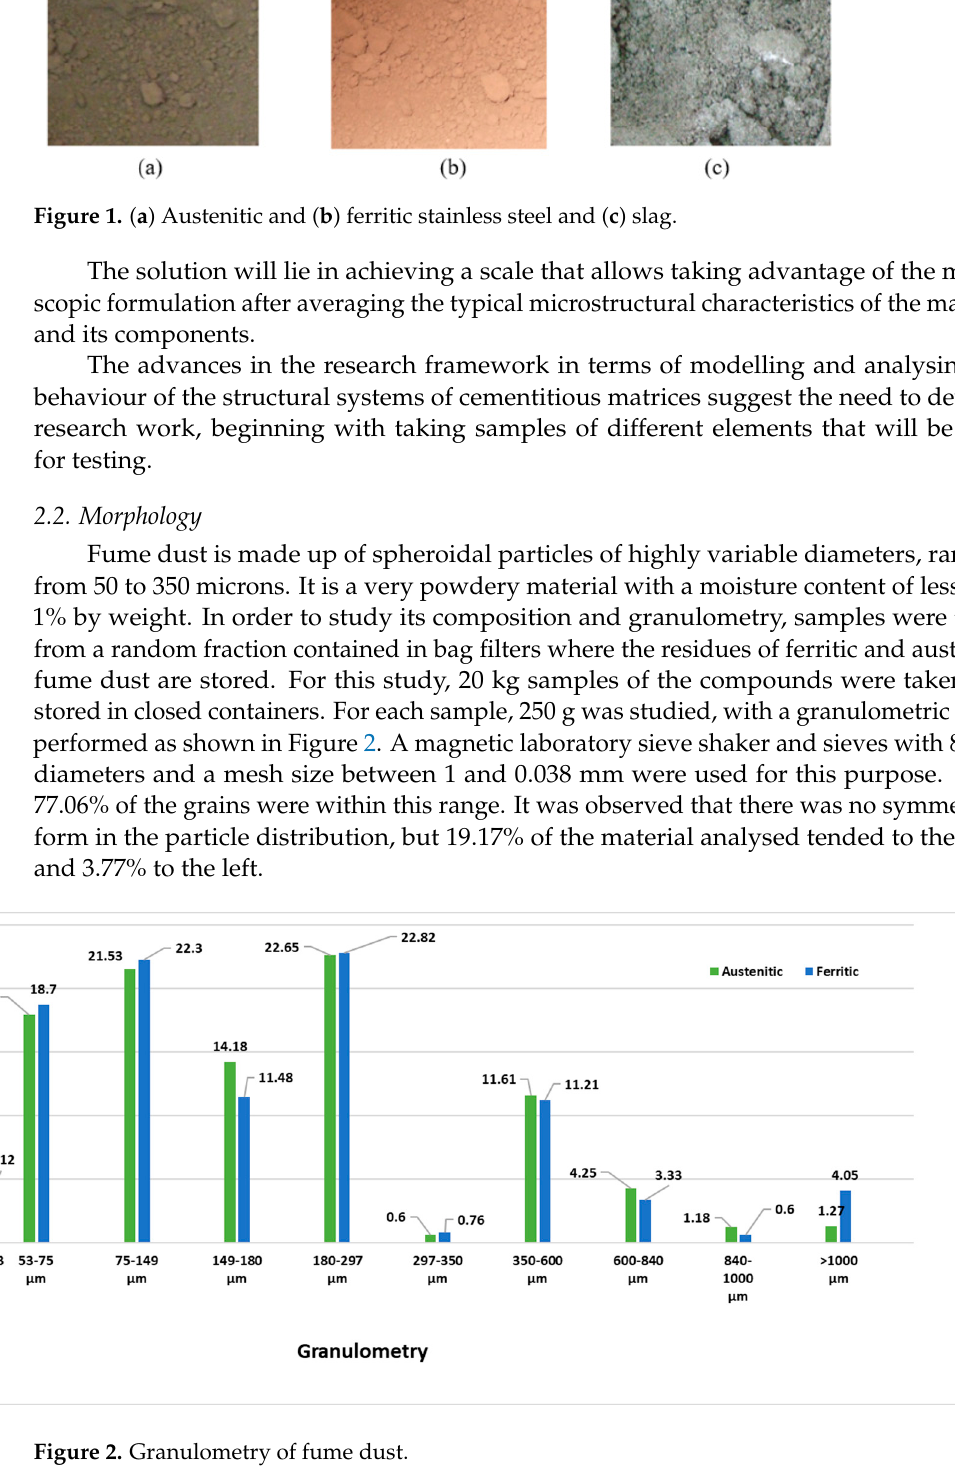
Figure 1. ( a ) Austenitic and ( b ) ferritic stainless steel and ( c ) slag.